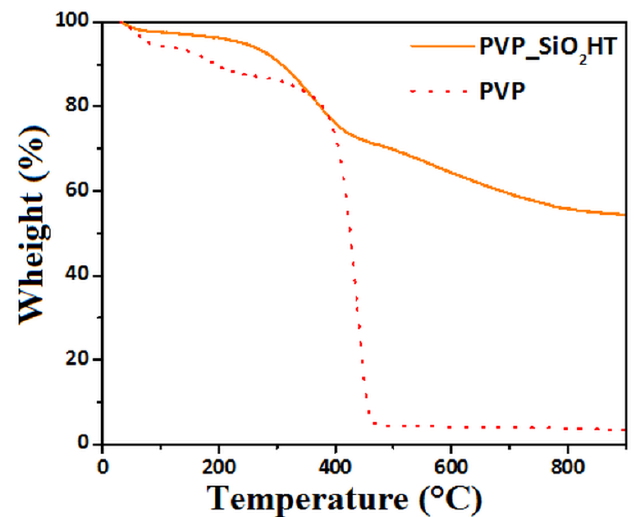
Figure 9. TGA of PVP and PVP_SiO 2 HT.